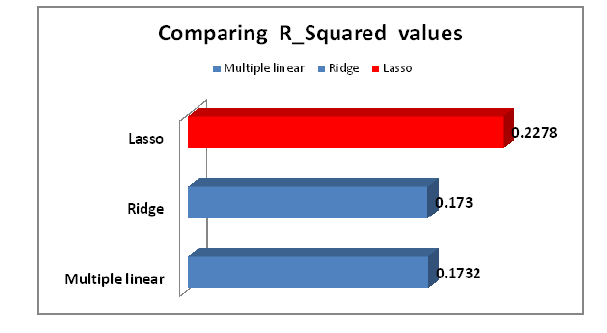
Figure 8. Comparing the algorithms using R_squared value